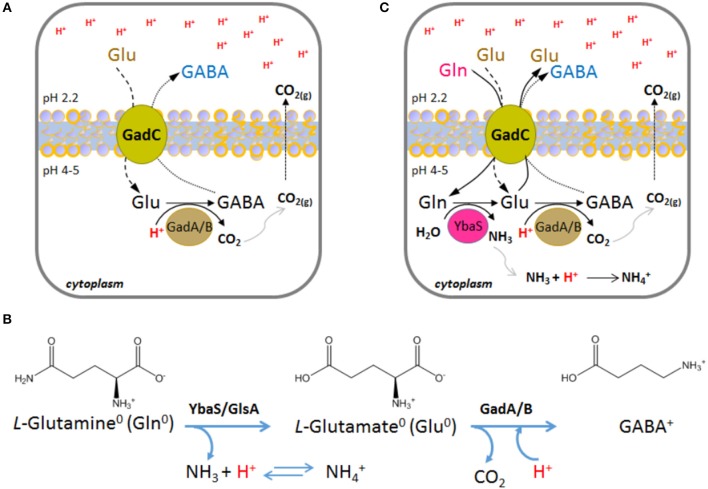
Schematic representation of the enzymatic reactions and transport activity in the AR2 and AR2_Q systems in Escherichia coli. (A) A typical situation where the AR2 comes into action is when the drop of the extracellular pH to below 2.5 leads, as a consequence, to the decrease of the intracellular pH to below 5. This activates the GadC-mediated import of Glu0 (if available extracellularly) and the export of GABA+, the latter generated by the intracellular proton-consuming activity of GadA/B. (B) Chemical structures and net charge of the species imported and exported by GadC, according to (Ma et al., 2013; Tsai et al., 2013). The reactions and the enzymes involved are shown. (C) A situation where the AR2_Q can be operative is when the extracellular pH drops below 2.5 and, as a consequence, the intracellular pH decreases to below 5. This activates the GadC-mediated import of Gln0 (when available extracellularly) and the export of Glu0 (arising from Gln deamination) or GABA+ (arising from Glu decarboxylation). In AR2_Q, protons are taken up during ammonium ion formation and during GABA synthesis. According to previous reports (Ma et al., 2013; Tsai et al., 2013), GadC can export either Glu0 or GABA+, depending on the cellular need to buffer the cytosol and effectively consume protons.